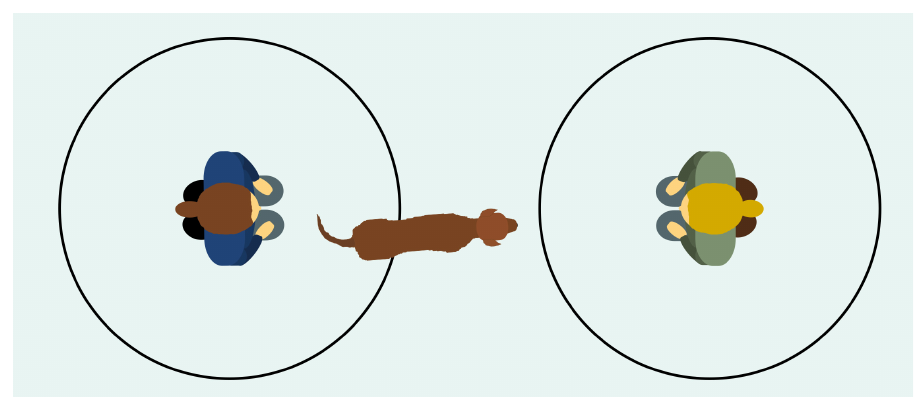
Fig 5. Free interaction session. The owner and the human partner with which the subject was tested on that day (helpful or unhelpful) knelt opposite each other in the middle of circles that were marked on the floor with tape (diameter = 2 m). The subject was released by its owner to roam free in the room, and to interact freely with the human partner or its owner, for 5 minutes.